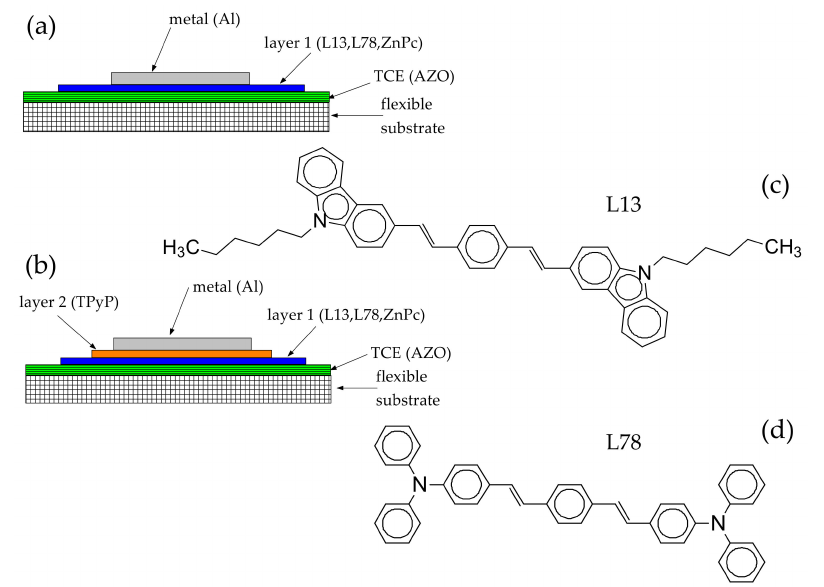
Figure 1. Organic heterostructures with single-layer organic ( a ), and bi-layer organic ( b ). Chemical structures of L13 ( c ) and L78 ( d